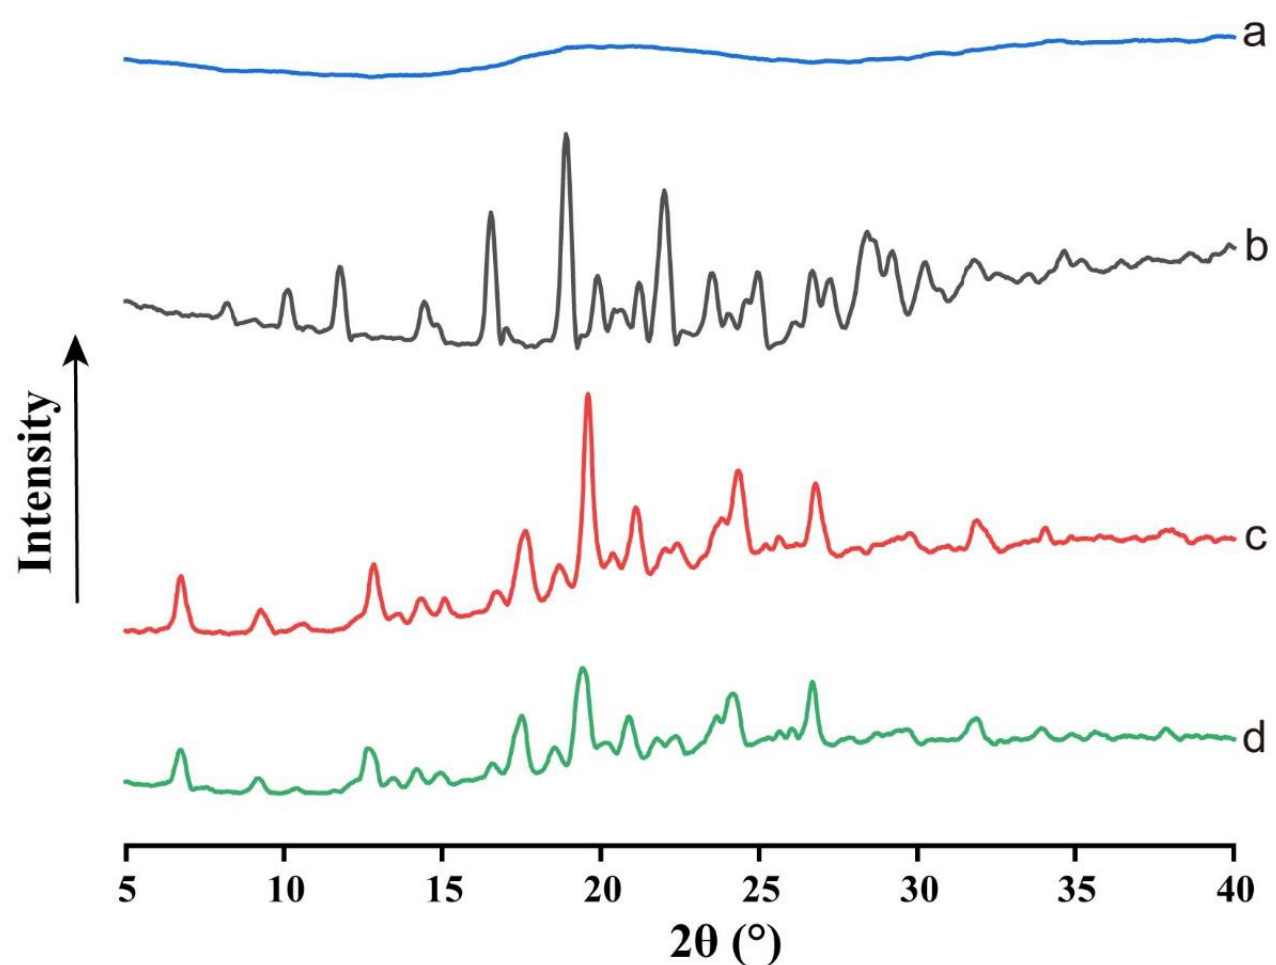
Figure 4. XRPD patterns of ( a ) amorphous ACM, ( b ) crystalline ACM, ( c ) monohydrate ACM and ( d ) ACM gels.